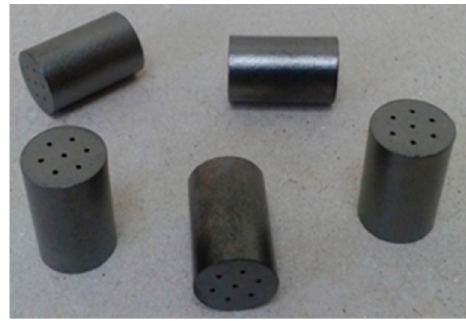
Figure 3. Image of LO5460 grains.